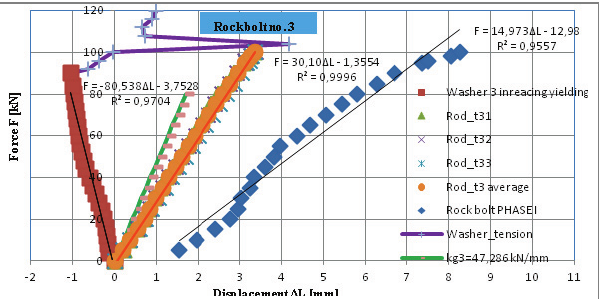
Fig. 20. The full loading characteristics for bolt No. 3 with the deformable component